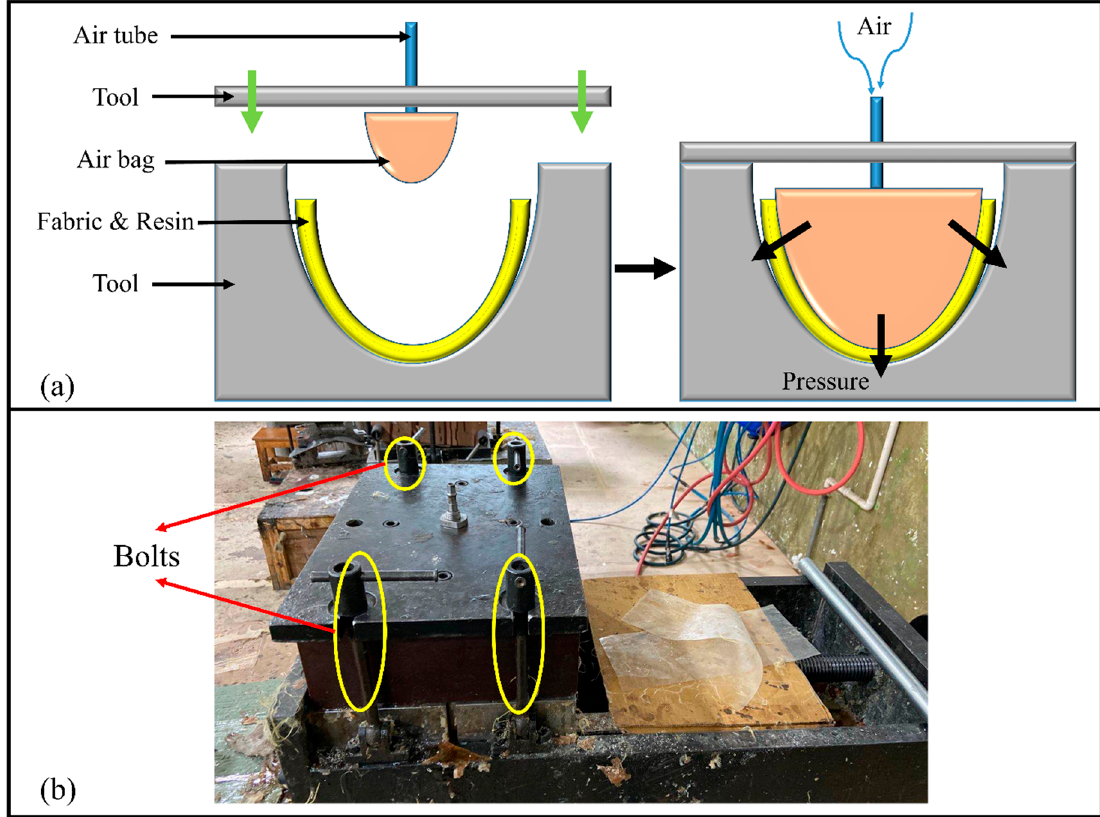
Figure 3. Sample preparing process: ( a ) A schematic diagram of air bag compression molding process; ( b ) Actual molding set-up.